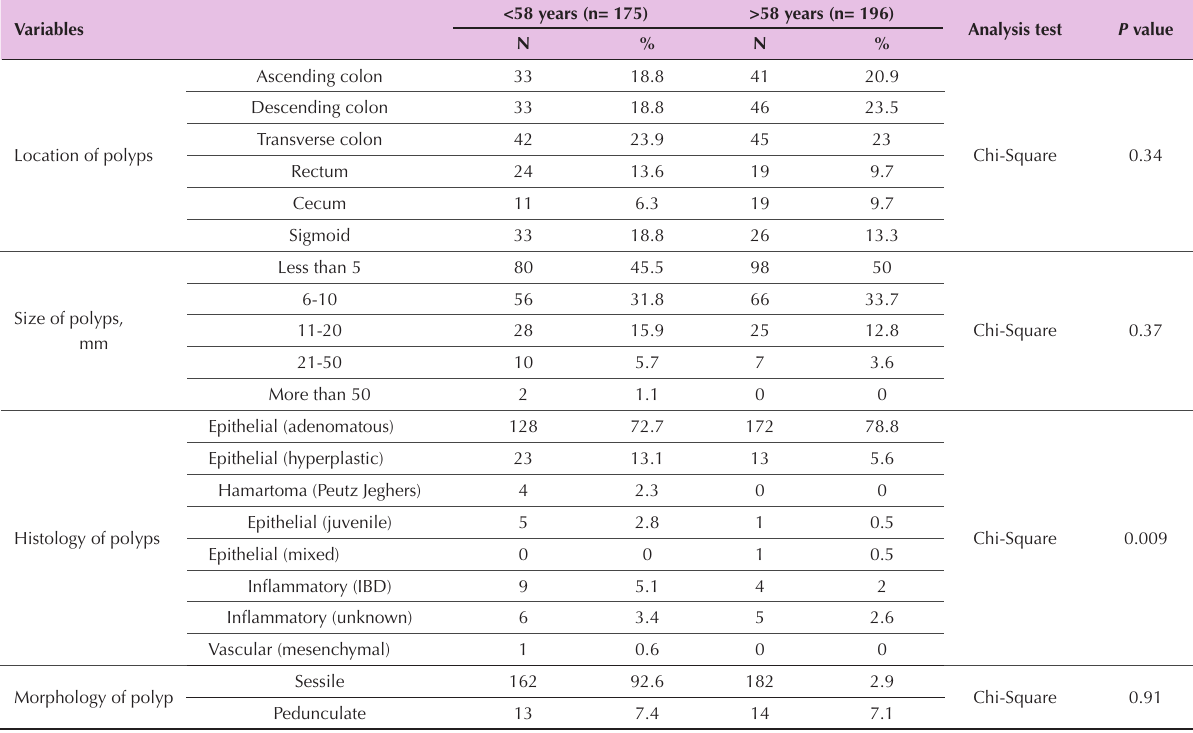
Table 2. Histologic and morphologic details of polyps based on age